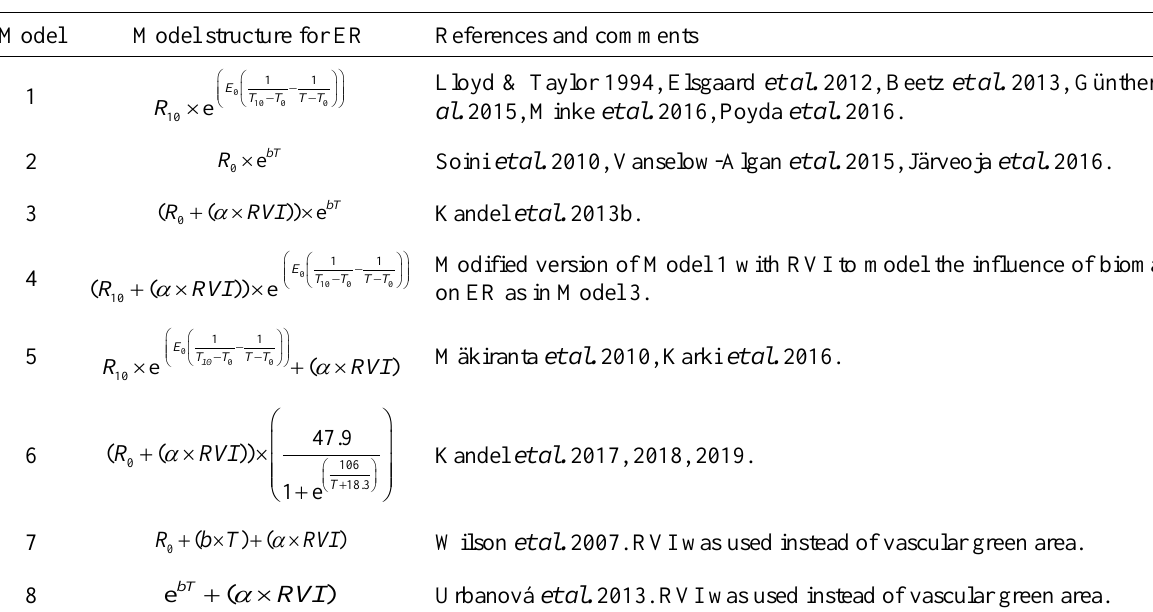
Table 1. Ecosystem respiration (ER) models adapted or modified from previous studies and used with the present